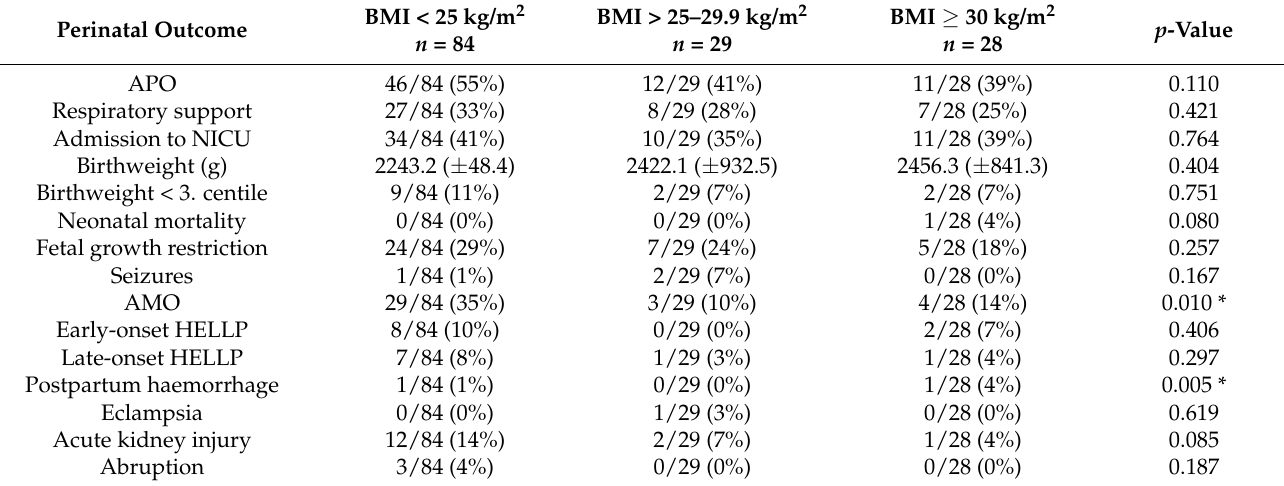
Table 2. Perinatal